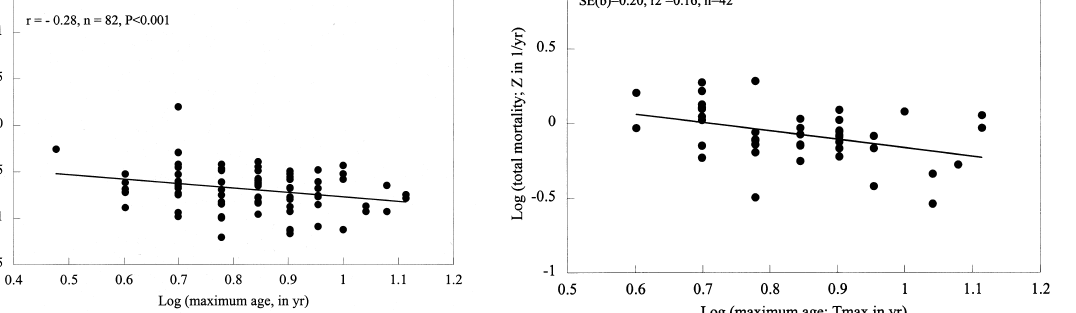
Fig. 10. Relationship between maximum age and total mortality for a variety of fish stocks in Hellenic